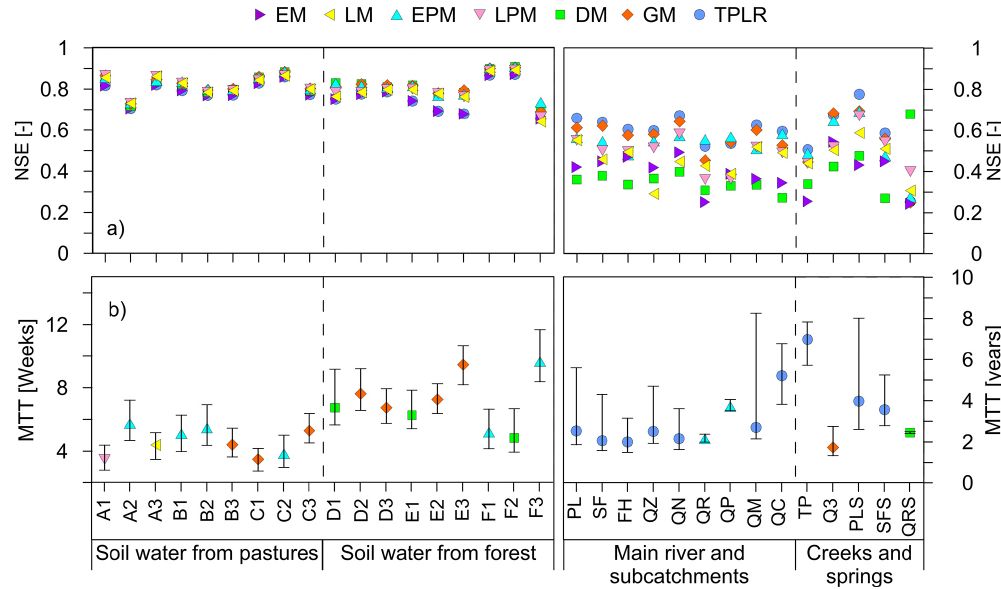
Fig. 5. (a) Best NSE for each of the seven lumped-parameter models; (b) MTT estimation according the best NSE per site: symbols represent MTT corresponding to the best-matching result among seven models considering the NSE criteria shown in (a) , while the vertical line represents uncertainty bounds according the GLUE methodology for the selected